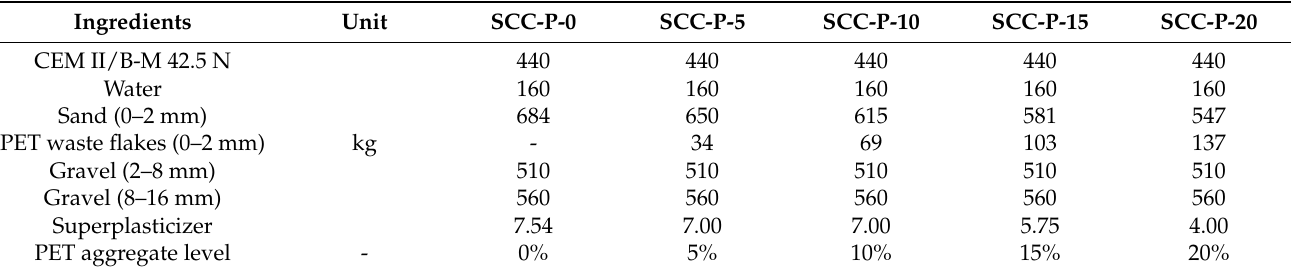
Table 3. The composition of the mixes used per cubic meter.